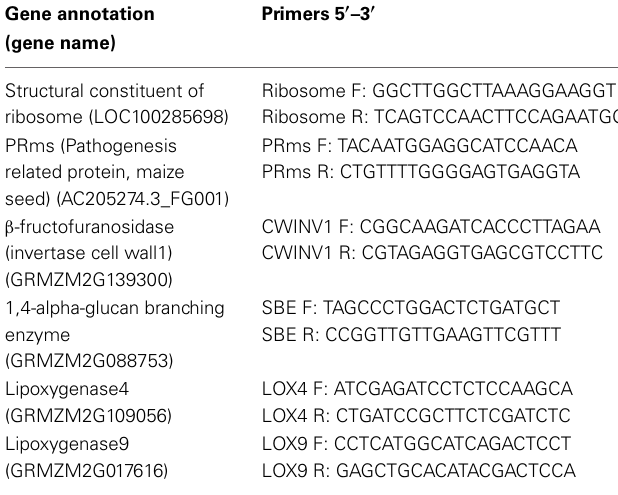
Table 1 | Primers used in